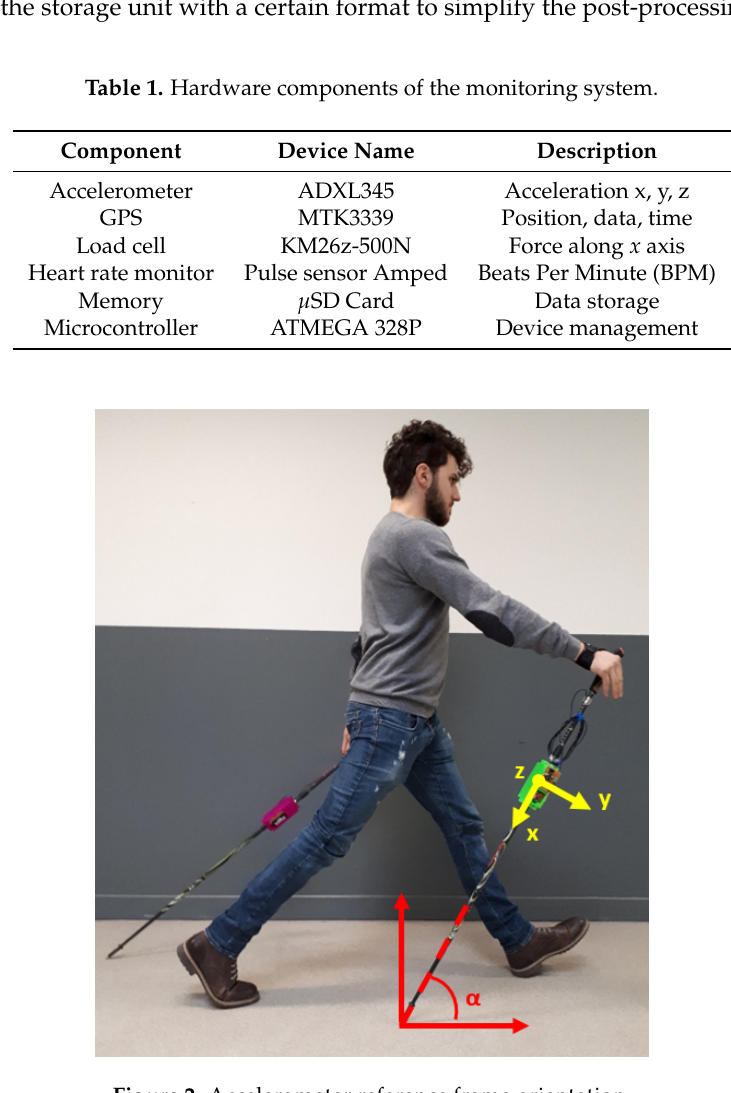
Figure 2. Accelerometer reference frame orientation.